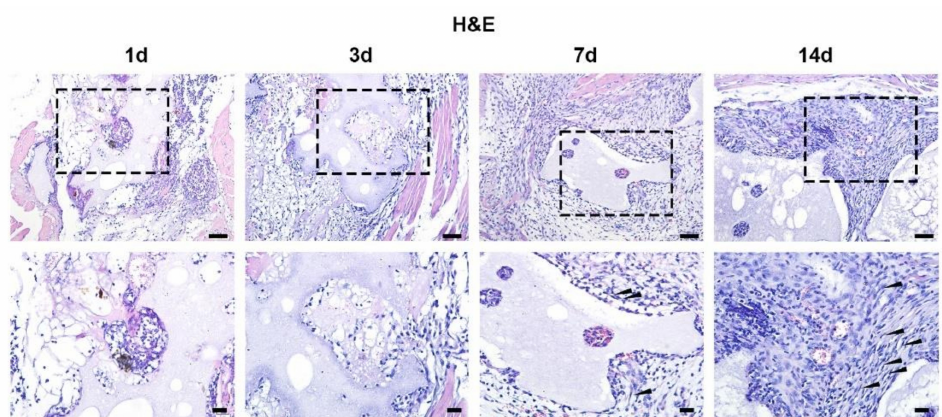
Figure 4. Biological reactions induced by BCP ceramics. Consecutive HE staining of BCP after implantation in muscle showed abundant immune cells infiltrated around BCP ceramics at day 3 after implantation and functional cells like fibroblasts emerged after 7-day implantation. Fibroblasts which are featured with spindle shape gathered around BCP ceramics at day 14 after implantation as indicated by black triangles in magnified images. Scale bar: 50 µ m and 20 µ m, respectively.